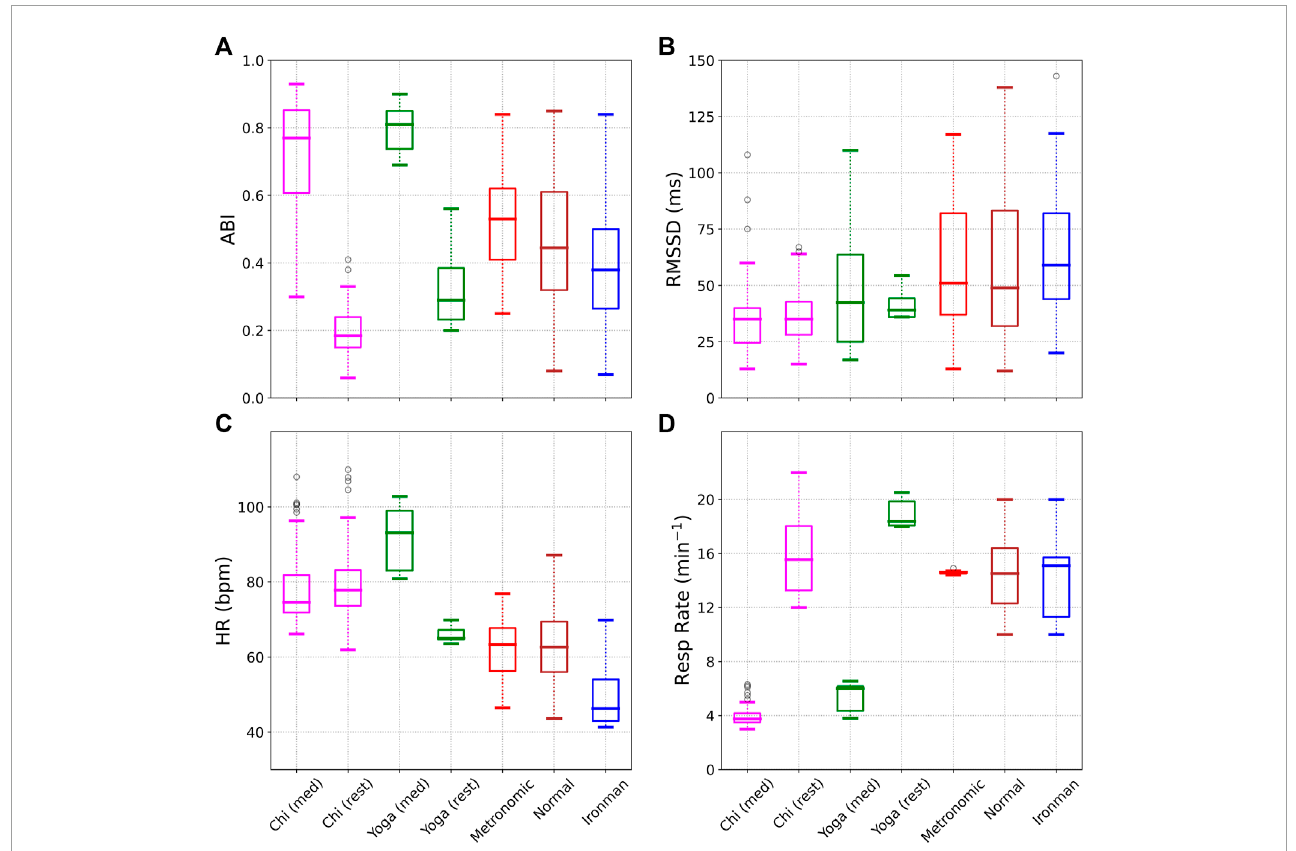
FIGURE 3 A comparison of the autonomic balance index (ABI), RMSSD, Heart Rate, and Respiratory Rate for the 7 different cohorts. ABI shows a very significant difference between the meditation and rest data, while such a difference is not seen in the RMSSD. The respiratory rate is also substantially decreased during meditation compared to the rest